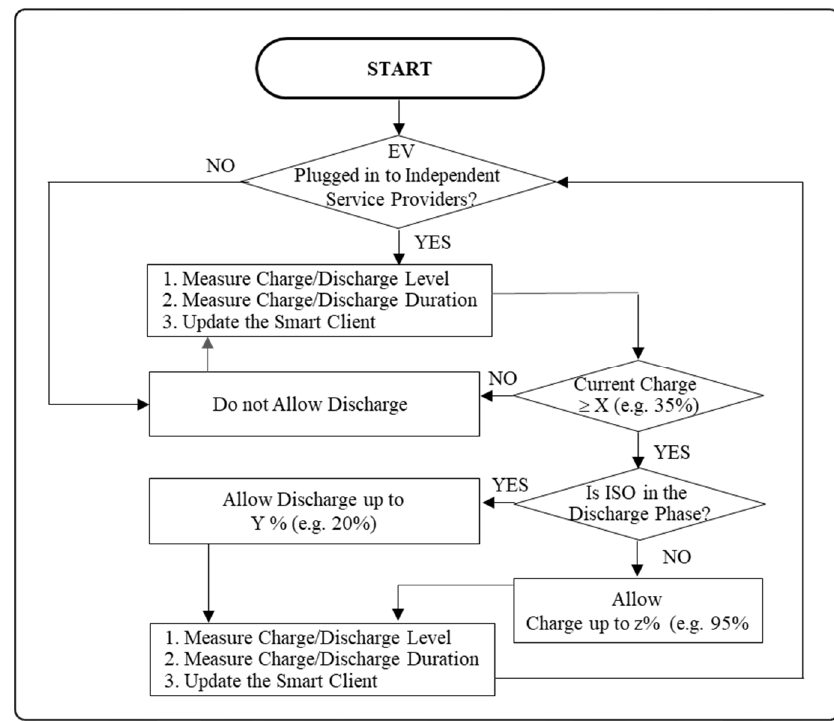
Figure 3. EV-batteries’ Change/Discharge Policy Algorithm.